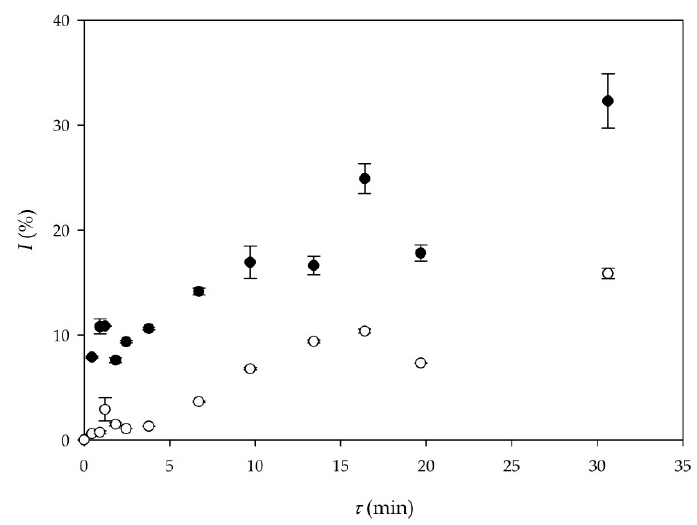
Figure 3. Comparison of biodiesel yield in different reaction mediums ( ● —buffer as a reaction medium (Experiment 6), ○ —DES as a reaction medium (Experiment 8)).